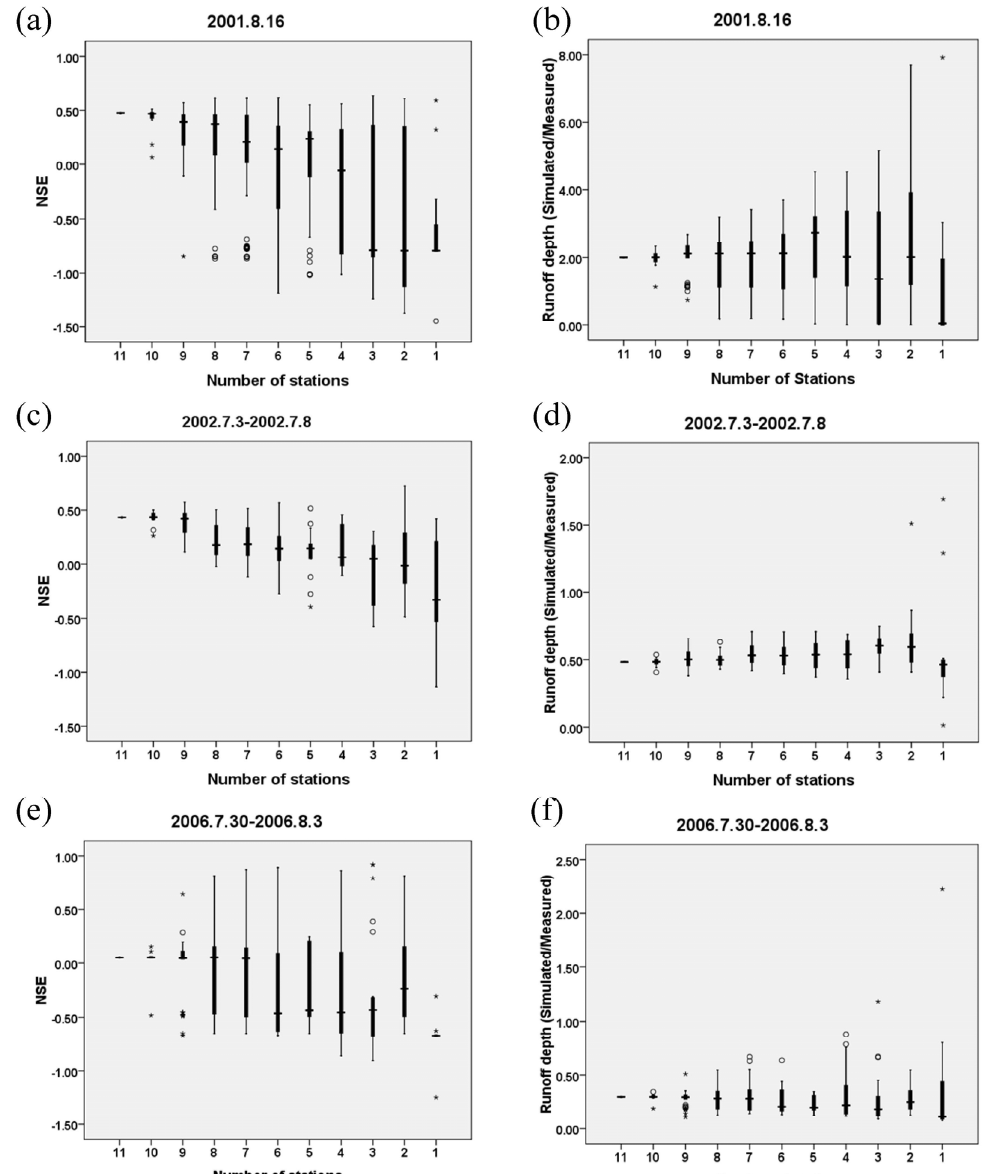
Figure 9. Performance of simulated runoffs of the three cases using different numbers of resampled stations in the upstream of the Qingjian River basin: ( a , c , e ) NSE; ( b , d , f ) the ratio of simulated runoff depth over measured.